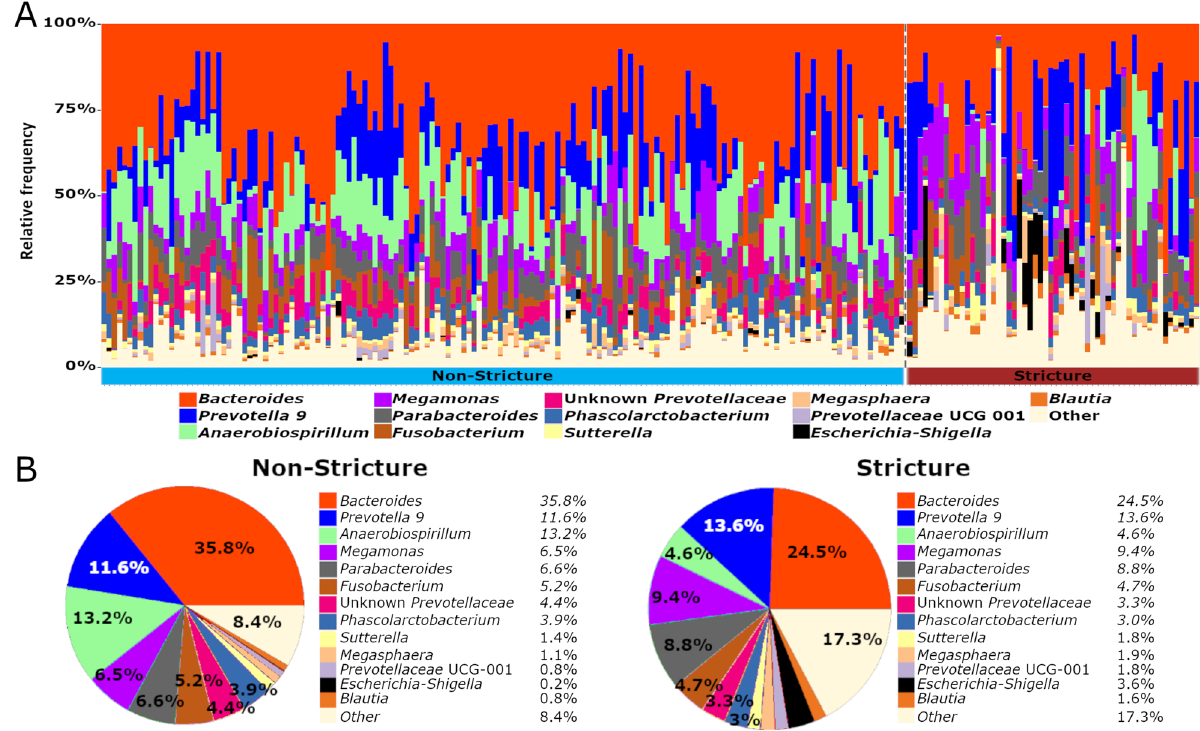
Figure 1. ( A ) Microbiome composition of individual samples at the genus level and ( B ) pie charts with average bacterial abundances of stricture (n = 57) and non-stricture marmosets (n = 153) show dysbiosis associated with stricture characterized by decreased Bacteroides and Anaerobiospirillum and increased Megamonas . Unique non-stricture animals Non-stricture samples Unique stricture animals Stricture